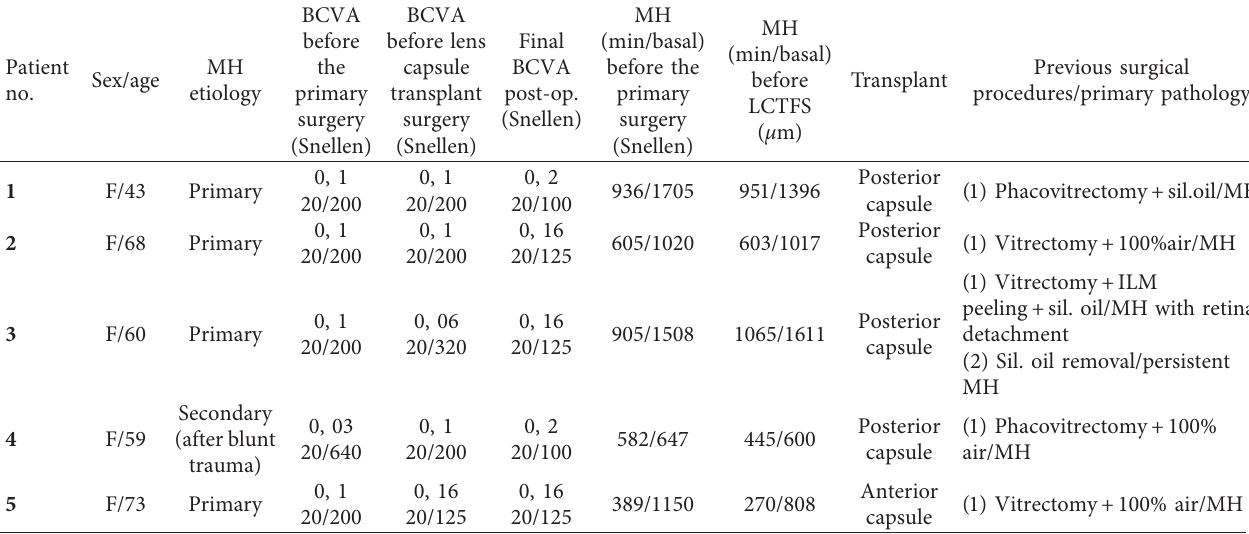
Table 1: Patients’